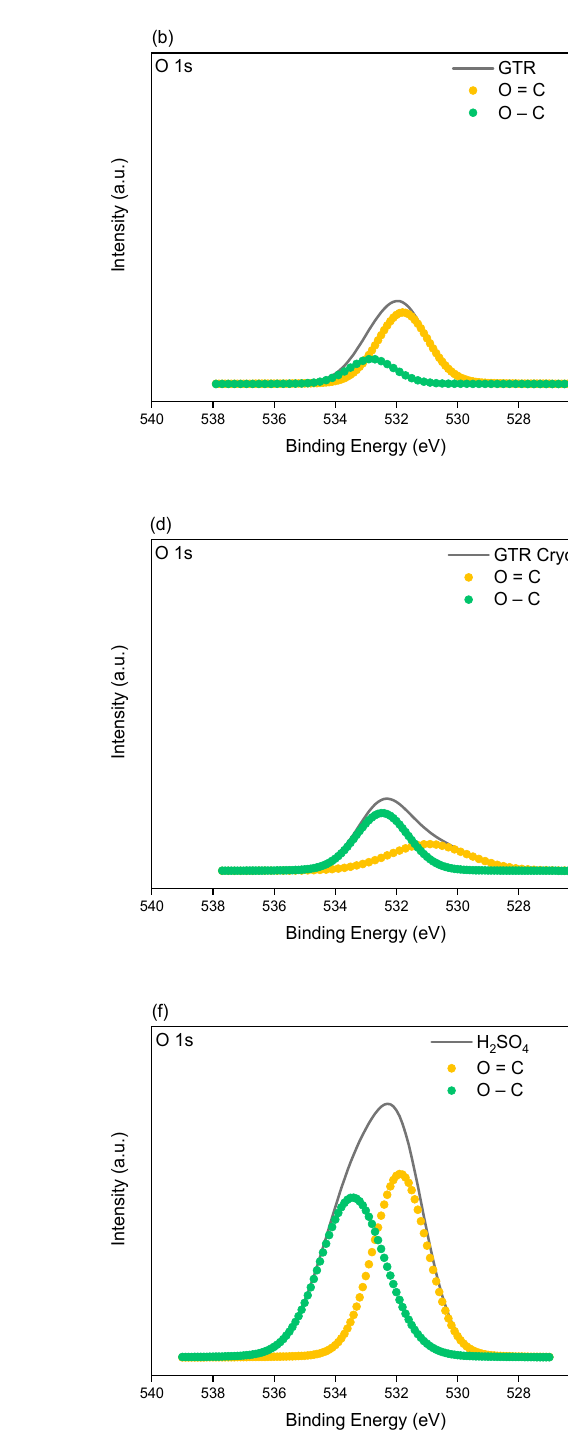
Figure 6. C and O core spectra of: ( a ) and ( b ) as-received GTR; ( c ) and ( d ) GTR Cryo; ( e ) and ( f ) GTR modified with H 2 SO 4 . The surface composition determined through the XPS of the as-received GTR and after chemical treatment is summarized in Table 4. Sulfur (S), oxygen (O), silicon (Si), and nitrogen (N) elements were present in different amounts depending on the chemical modification. The as-received and cryo-ground GTR showed subtle changes in their composition. The existence of a lower amount of O in as-received GTR and in GTR Cryo would be reasonable due to carbonate additives and metal oxides; moreover, the presence of O in modified samples was directly related to the various oxidation treatments. The